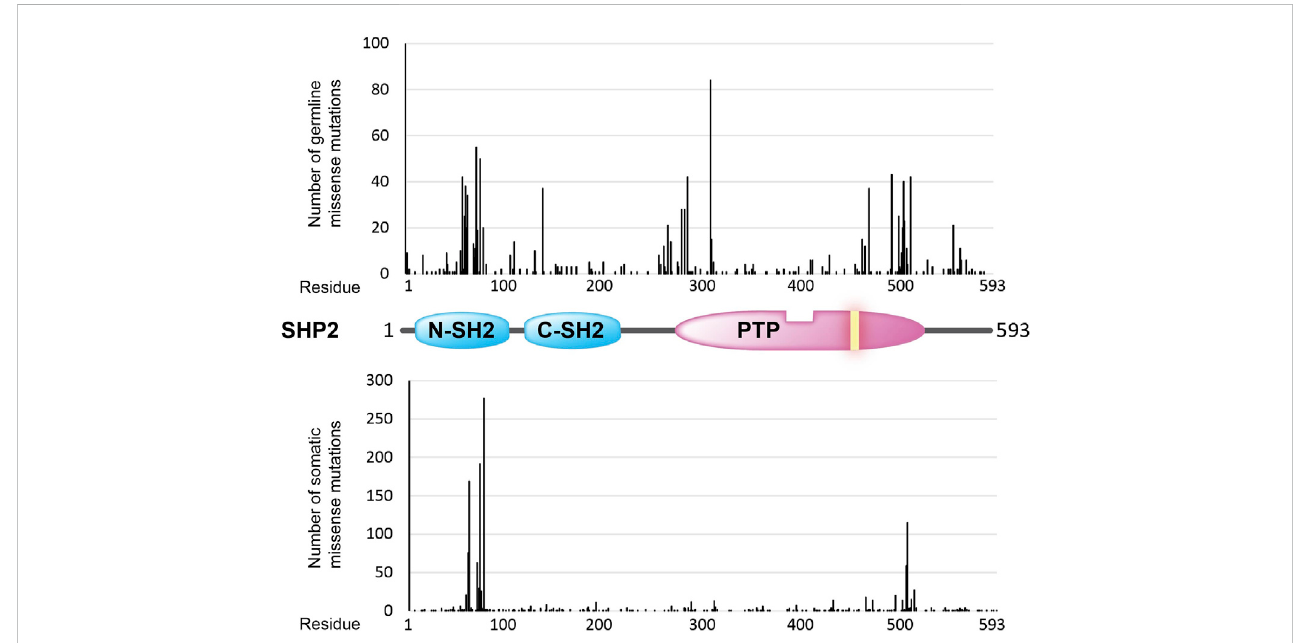
FIGURE 3 Overview of amino acid positions ( x -axis) in the SHP2 protein (structural cartoon in the middle) that are found mutated (missense mutations) in the germline (top graph; ClinVar counts) and in sporadic cancer cases (lower graph; COSMIC counts). Occurrence frequencies ( y -axis) are represented by the vertical black bars. The catalytic PTP domain and the Src homology type 2 (SH2) domains are depicted as in Figure 1. The yellow bar in the PTP segment indicates the position of the essential catalytic site